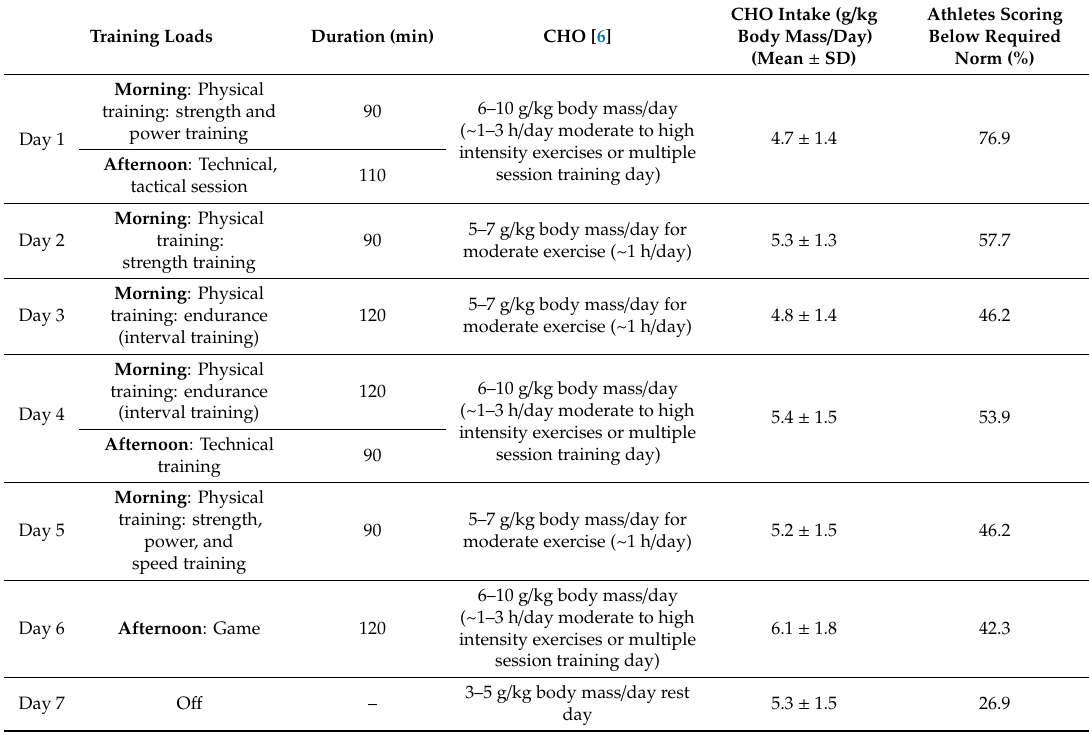
Table 2. Training loads during one week of the preparatory period and comparison of carbohydrate targets to carbohydrate intake by studied